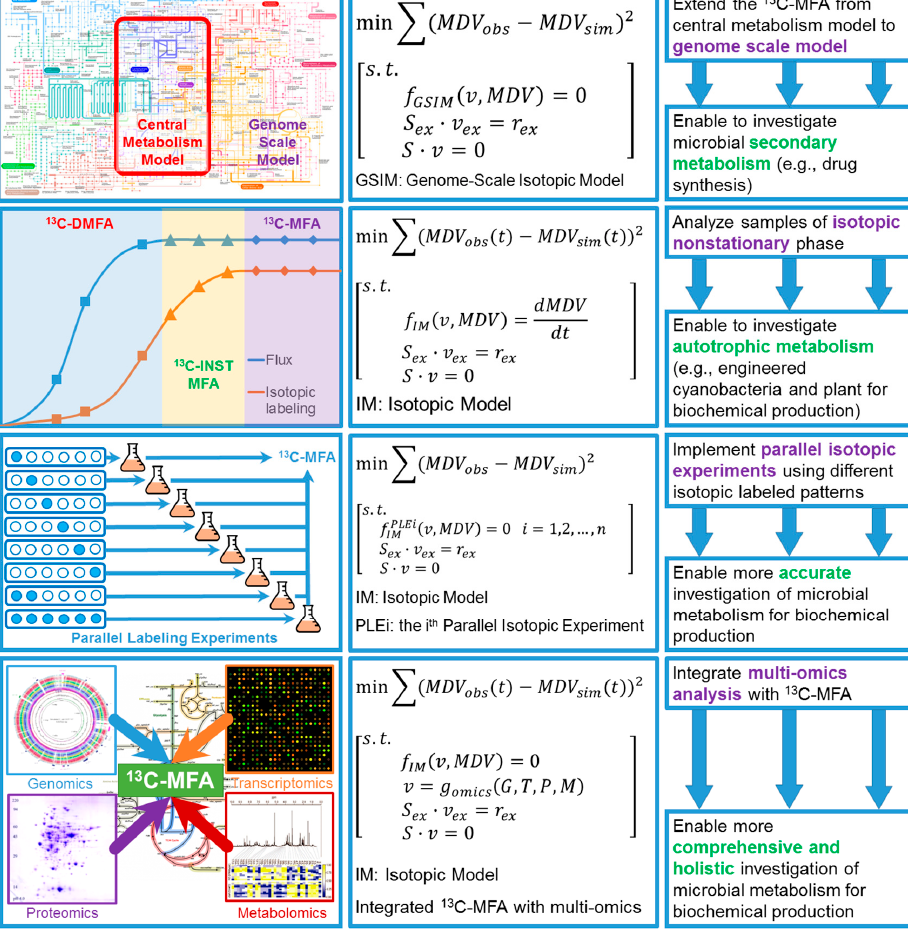
Figure 5. Recent advances and perspectives of 13 C-MFA, including diagrams (left column), mathematical representation (middle column), and detailed descriptions of recent advances of 13 C-MFA (right column).